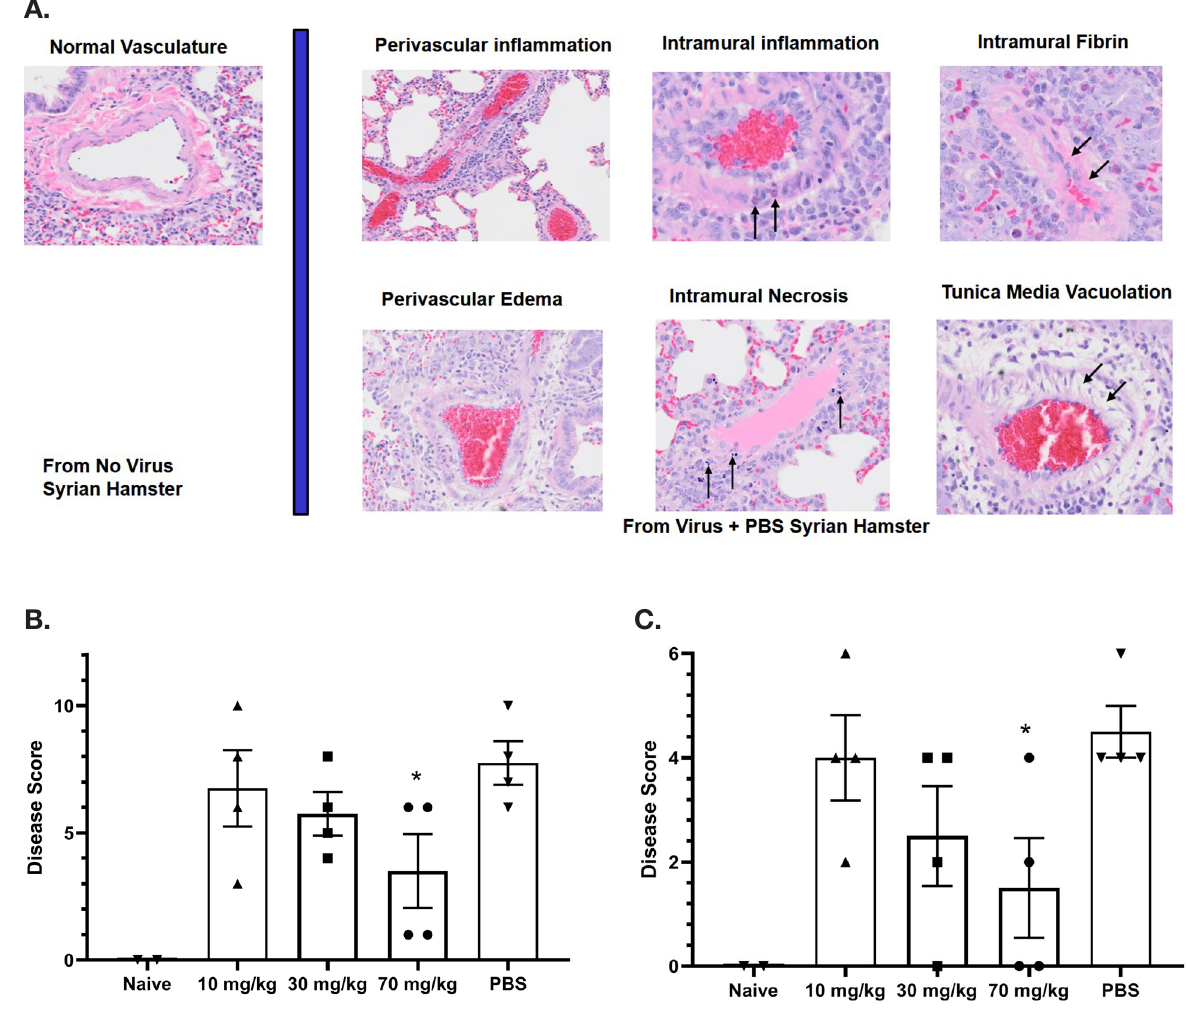
Figure 4. Assessment of Lung Pathology in the Syrian Hamster Efficacy Study. (A) Representative vascular histopathology slides from control (no virus) and virus plus PBS groups. Arrows indicate inflammatory cells within the blood vessel wall (intramural inflammation), necrotic cellular debris